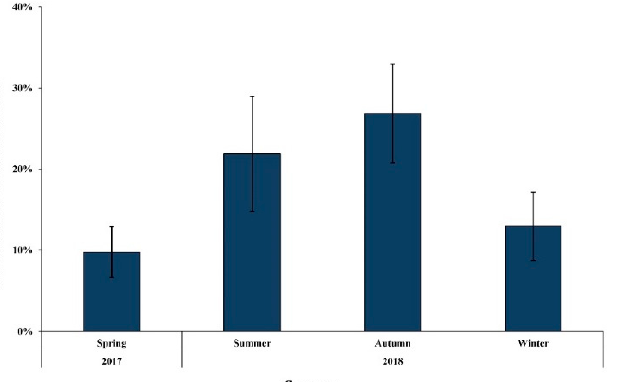
Figure 10. Seasonal variations in percent TEP-C of total POC at the JBS during our sampling period.